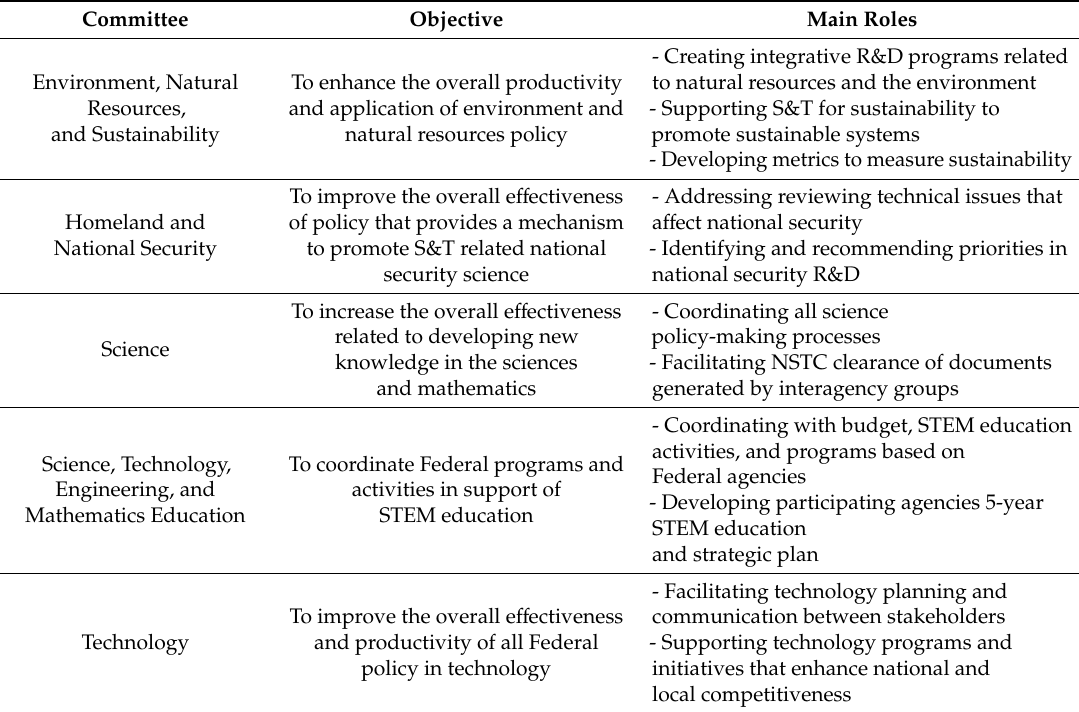
Table 4. Subcommittees of the